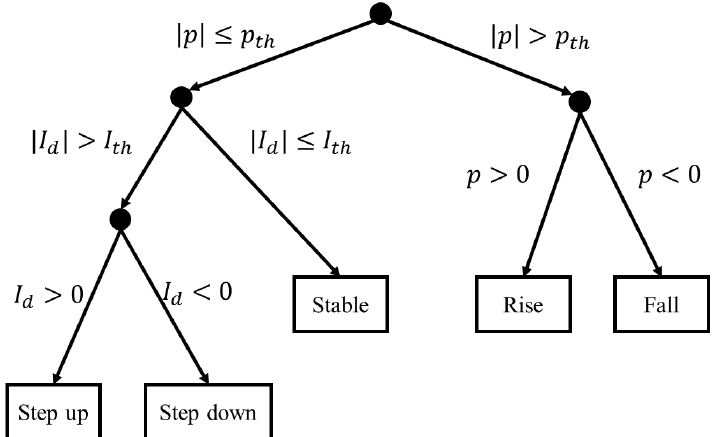
Figure 5. The rule of the trend recognition.